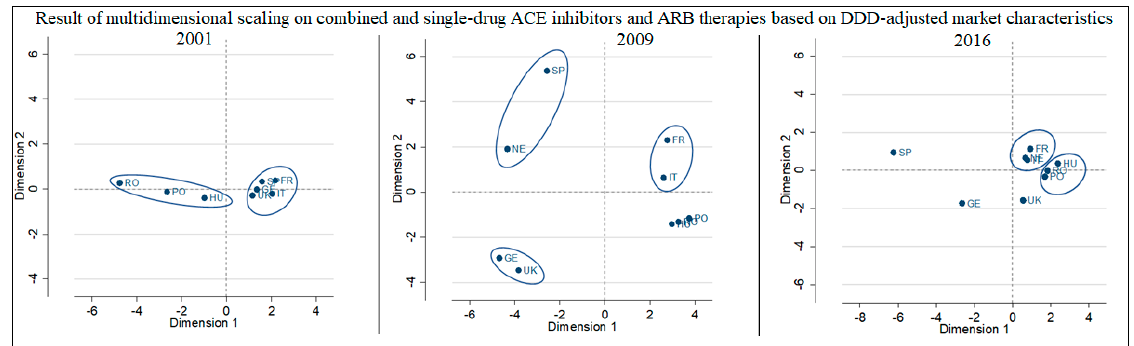
Figure 1. Result of multidimensional scaling of combined and single-drug ACE inhibitors and ARBs based on DDD-adjusted market characteristics of 2001, 2009 and 2016: 2001: r = 1.0000, ρ = 0.9984, Kruskal’s stress index: 0.0056; 2009: r = 1.0000, ρ = 0.9999, Kruskal’s stress index: 0.0045; 2016: r = 1.0000, ρ = 0.9990, Kruskal’s stress index: 0.0048.